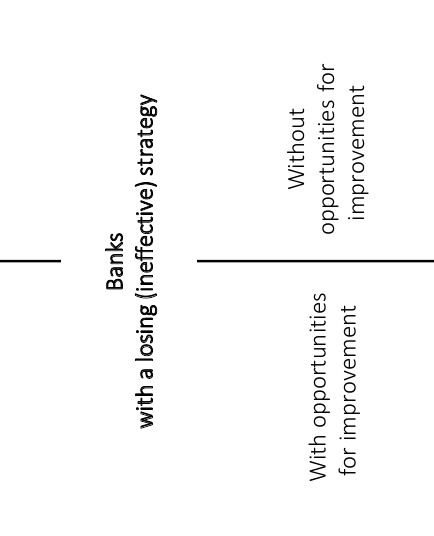
Figure 1. The matrix of a bank’s development strategy